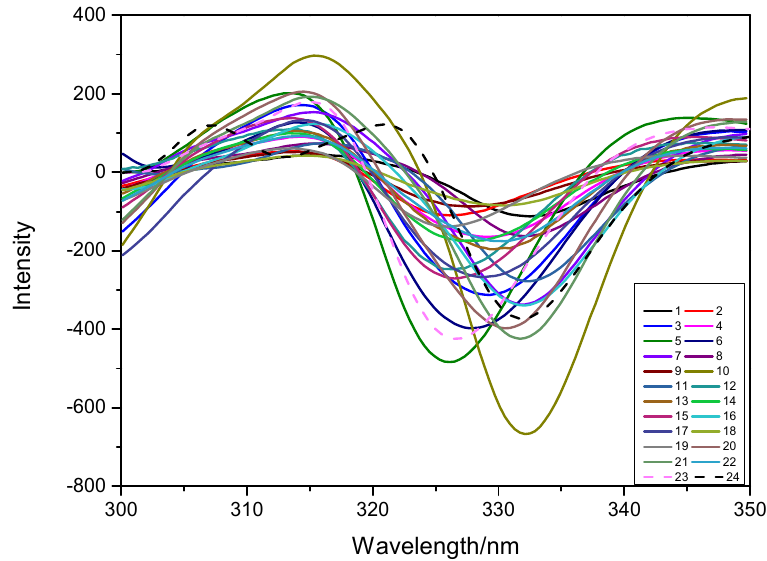
Figure 3. Second derivative constant-energy synchronous fluorescence spectra of 24 calibration sets.